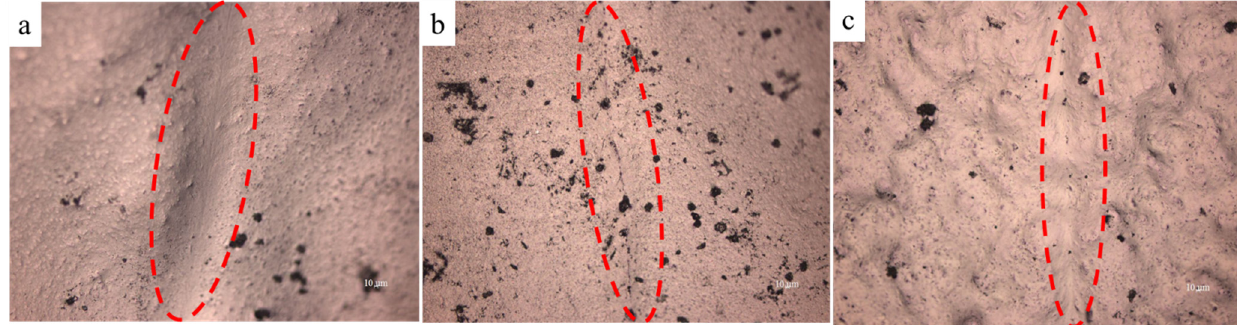
Figure 14. Optical images of scratch sample with 2 wt % GO and TPU initial concentration of 10 wt % ( a ), 20 wt % ( b ), and 30 wt % ( c ), respectively, healed at 130 °C for 10 min using IR lamp.